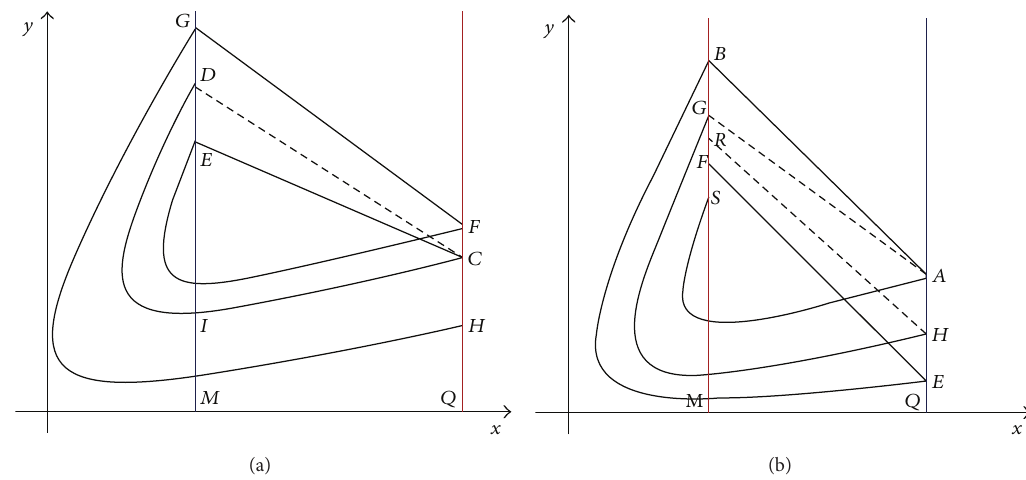
Figure 3: It represents the proof on Theorem 17. In (a) and (b), the line 𝑀 and the line 𝑄 represent impulsive set and phase set, respectively. The cures represent trajectory of system (1), and the lines denote impulsive line of system (1).